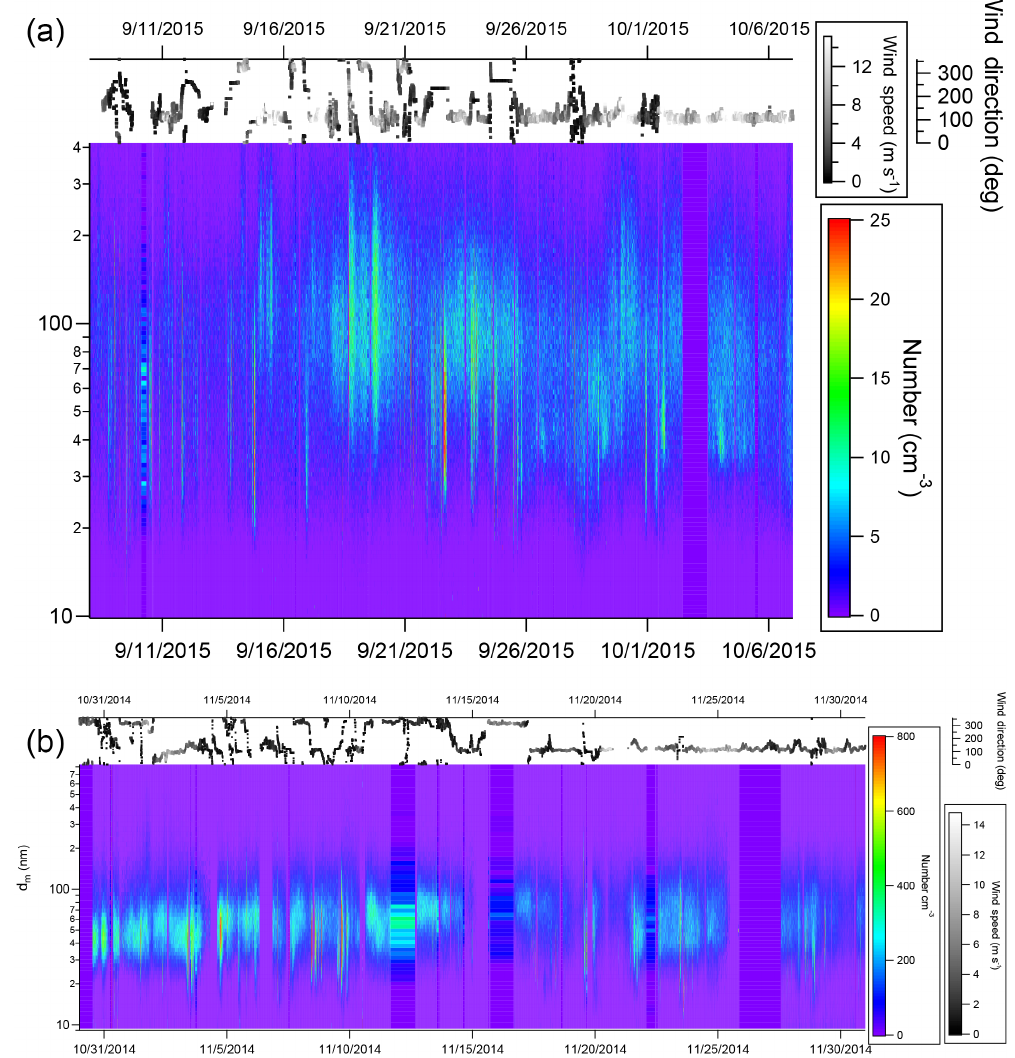
Figure A3. d N / dlogD p image plots from the particle sizing instruments for the 2015 ( a , SMPS) and 2014 ( b , SEMS) field seasons. Included are the wind speed and direction records. Note that small (20–30nm) particle enhancements only happen during calm-wind periods that coincide with elevated m/z 55 concentrations in the AMS (not shown), indicating generator